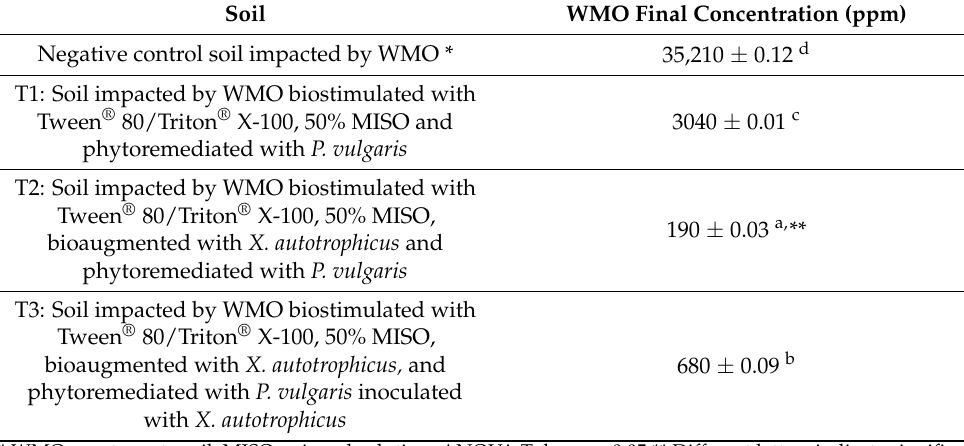
Table 6. Final concentration of waste motor oil in agricultural soil after three months of biostimulation, bioaugmentation, and two months of phytoremediation.